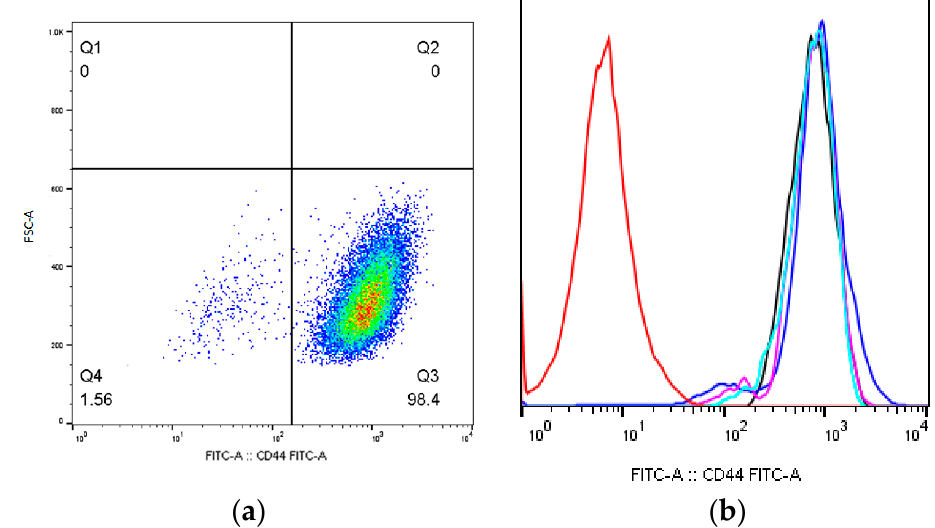
Figure 4. The CD44 expression level one of the donors MSCs 9 days after irradiation at dose of 50 mGy: ( а ) pseudocolor scattergram of stained CD44 dim and CD44 + population; ( b ) histogram of unstained control (red), stained non-irradiated control (black), and CD44 dim and CD44 + population of